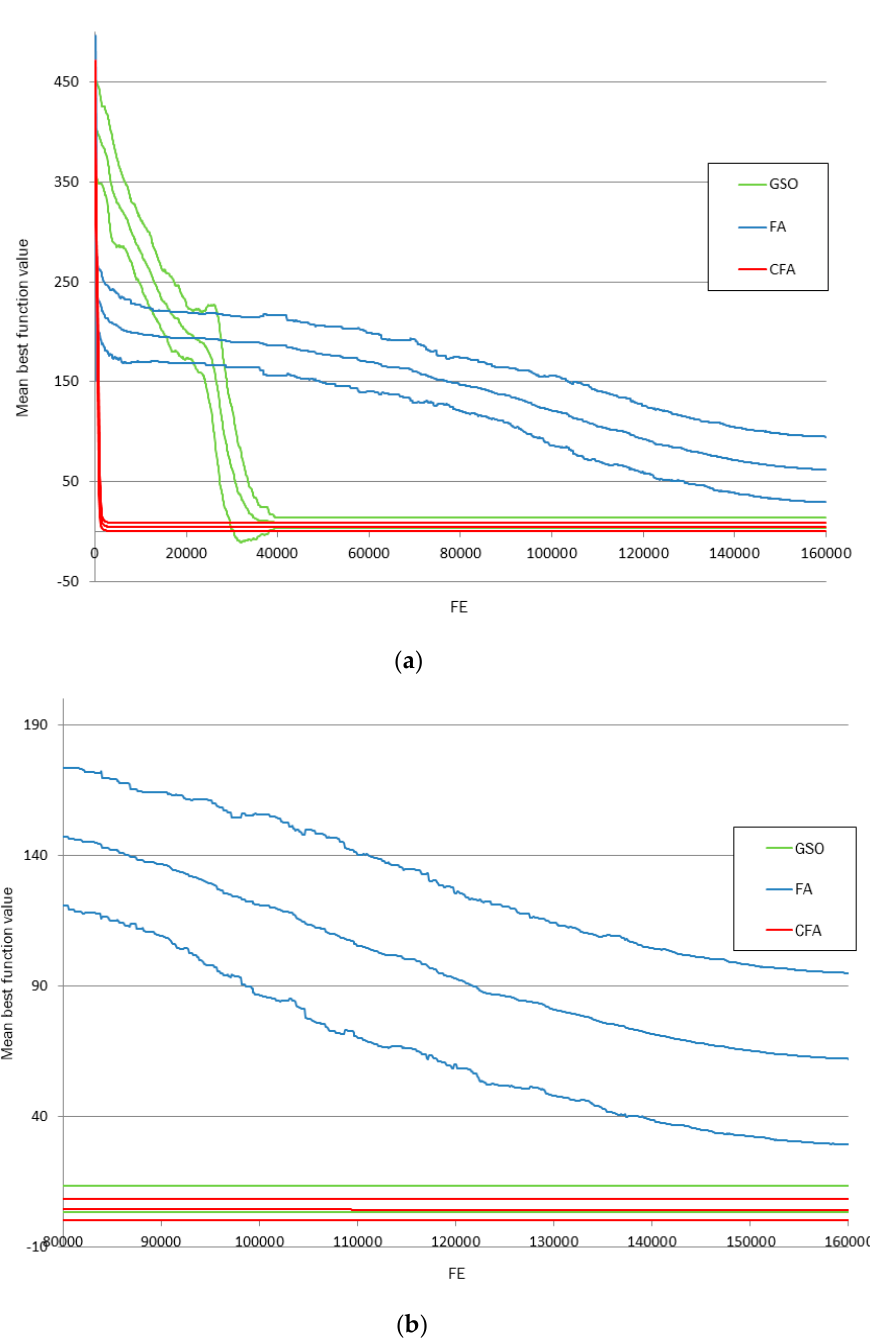
Figure 6. Online performance analysis with 95% confidence interval for the Rastrigin (30) function. ( a ) The convergence of the best function value during the whole duration of the execution. ( b ) The convergence of the best function value during the second half duration of the execution.